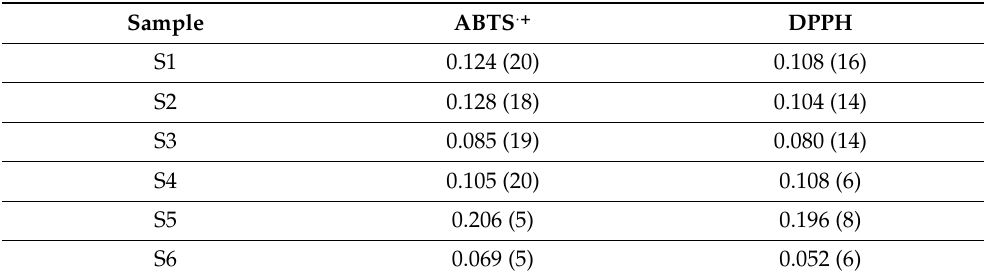
Table 5. Results (mmol TE/g DE) obtained in ABTS · + and DPPH assays for M. oleifera food supple- ments. RSD (%) values in